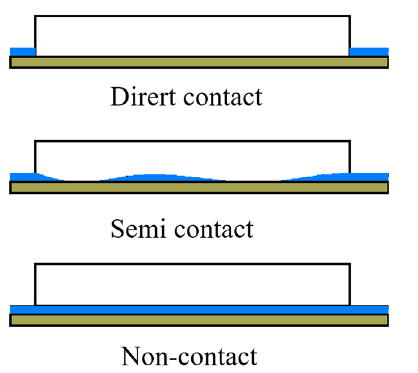
Figure 2. Contact modes between the optical element and polishing lap.